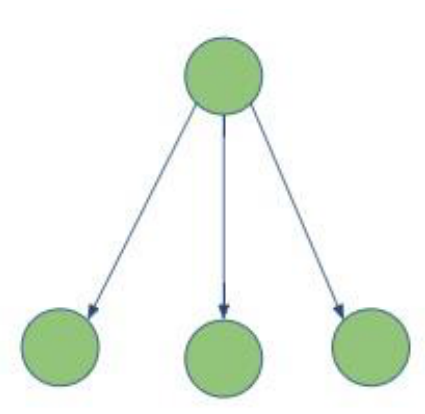
Figure 5. Visual representation of adoption by